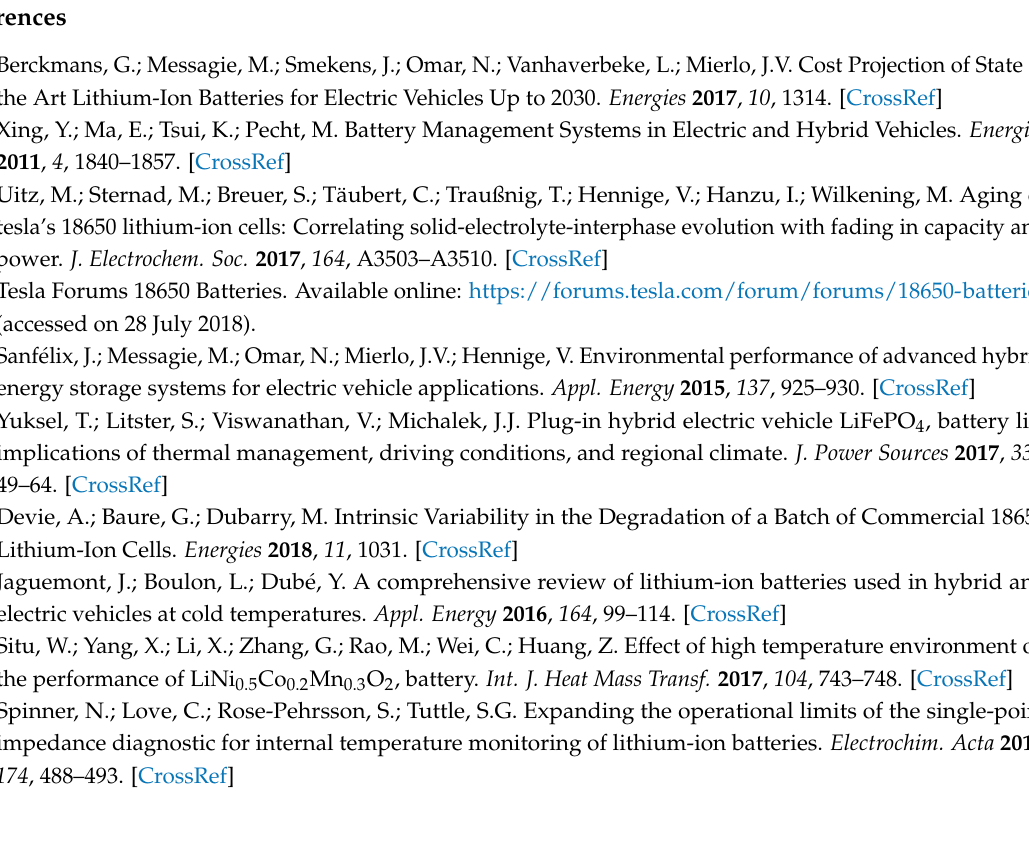
s1, Figure S1: Indelb T12R test incubator, Figure S2: The five temperature gradient, Figure S3: The vibration test bench, Table S1: The specifications of the Indelb T12R, Table S2: The specifications of the vibration test bench, Table S3: The test schedule of